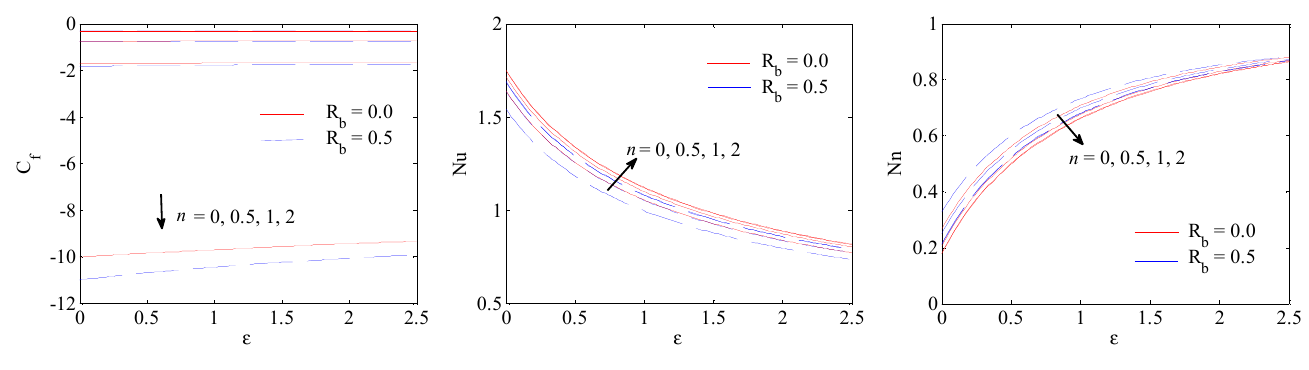
Figure 4. Fluctuations of C (cid:2916) , Nu and Nn due to n factor.